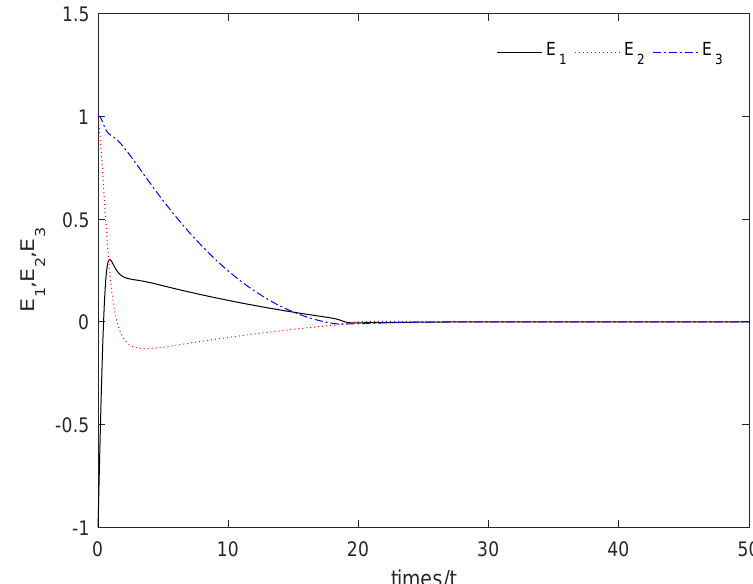
Figure 1. The sum system (21) is asymptotically stable.